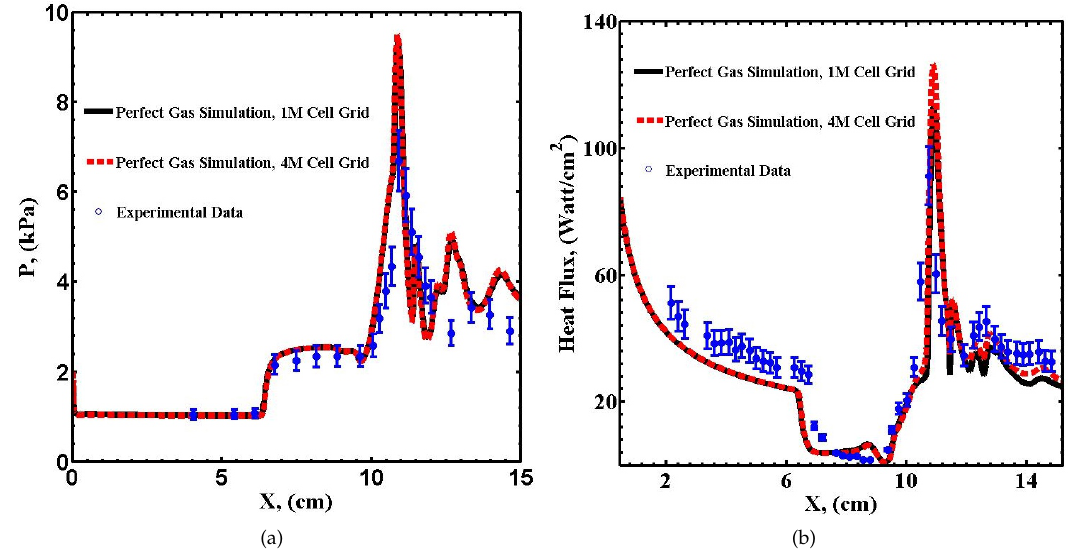
Figure 5. Computed results for Run 1, Table 1, for different grid refinement levels. ( a ) Surface pressure;